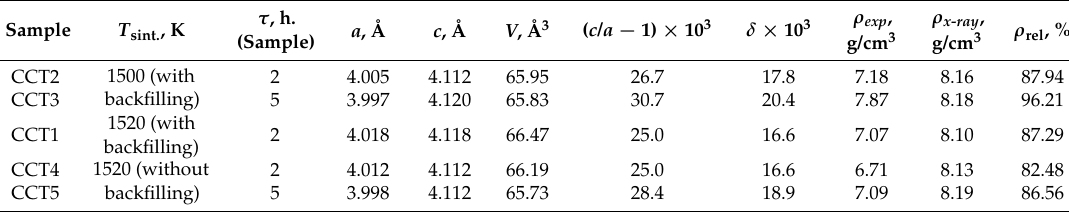
Table 2. Parameters = a , c and c / a ; volume = V ; ceramic densities: experimental = ρ exp ; X-ray = ρ x − ray ; and relative = ρ rel of PCR-13 material under different sintering conditions.